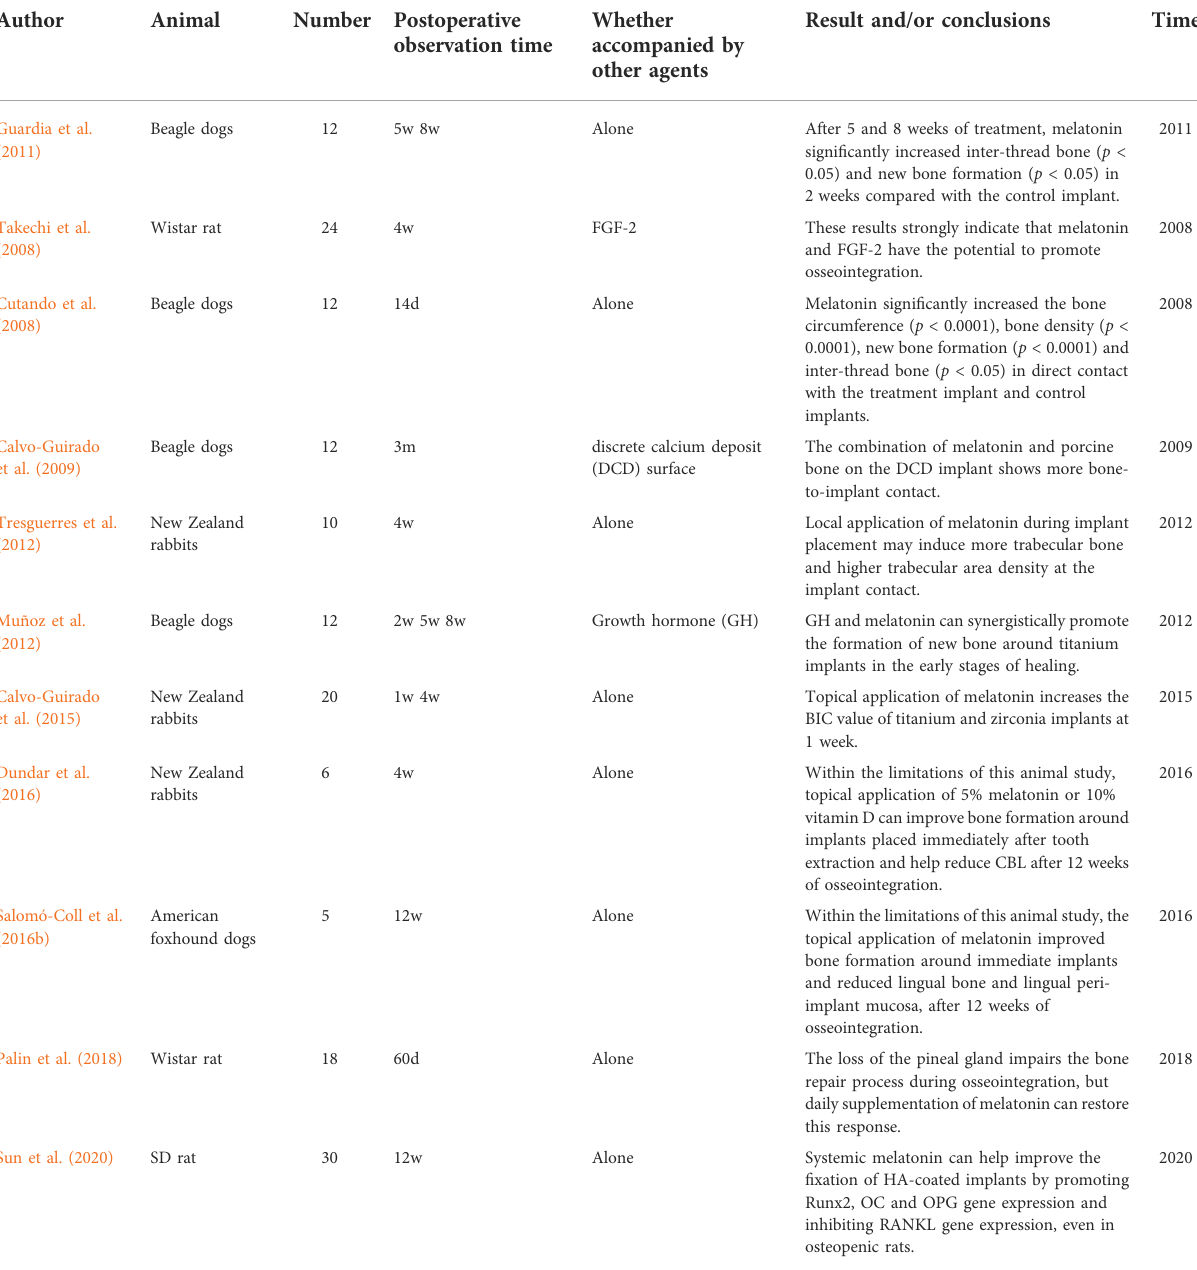
TABLE 2 Summary of studies focusing on the use of melatonin in dental implant